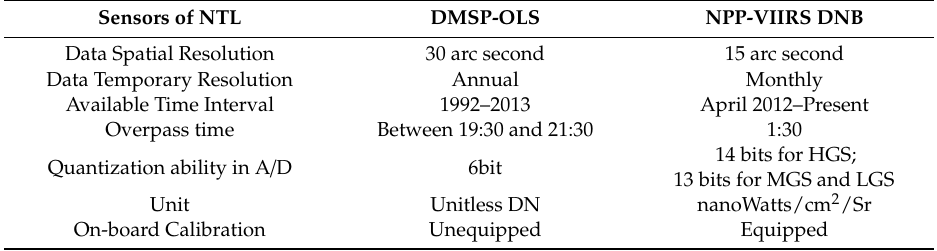
Table 1. PropertiesofDefenseMeteorologicalSatelliteProgram’sOperationalLinescanSystem(DMSP-OLS) and National Polar-orbiting Partnership Satellite’s Visible Infrared Imaging Radiometer Suite (NPP-VIIRS).